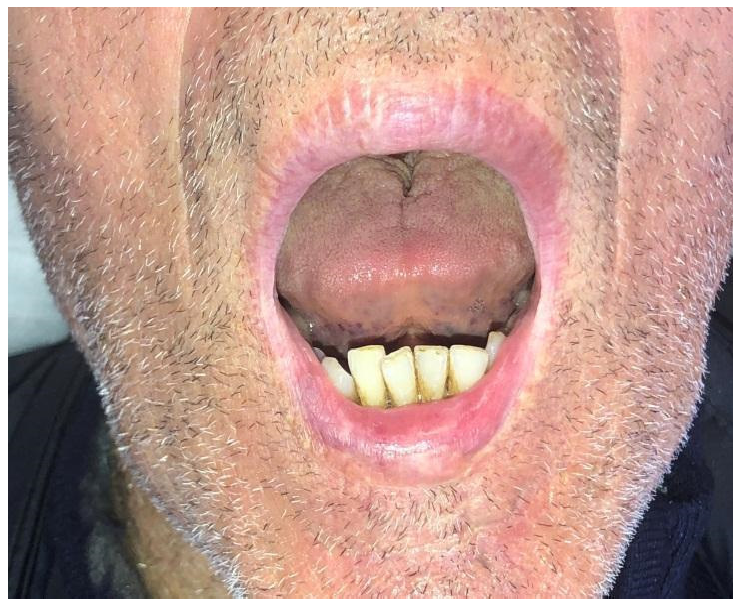
Figure 4. Case 1: Follow up at sixth months. Dynamic position.